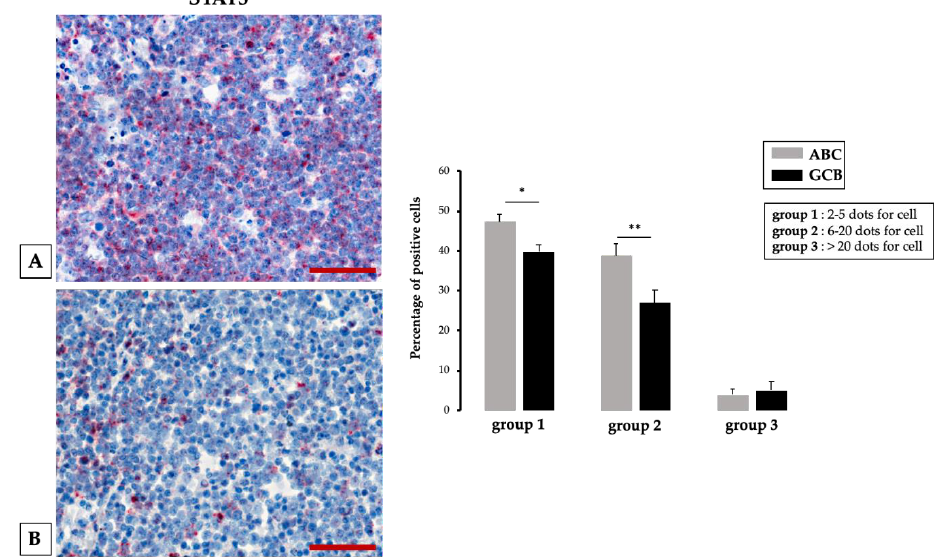
Figure 3. Left panel: different STAT3 expression in histological samples from activated B cell (ABC) ( A ) and germinal center B cell (GCB) ( B ) DLBCL assessed by RNAscope. Scale bar: 60 μm. Right panel: quantification of RNA ISH staining of STAT3 messenger RNA (mRNA) positivity in ABC and GCB DLBCL samples. The percentage of STAT3 mRNA expression significantly increases in the ABC group 1 and 2 tumor samples compared to GCB; * p < 0.05; ** p < 0.01, assessed by Mann – Whitney test. Representative images from 30 untreated DLBCL patients are presented [115].